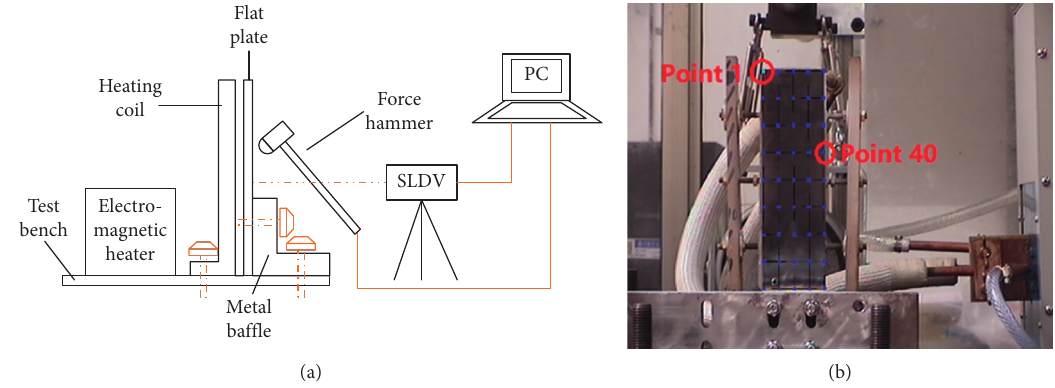
Figure 12: (a) The experimental setup. (b) The measurement